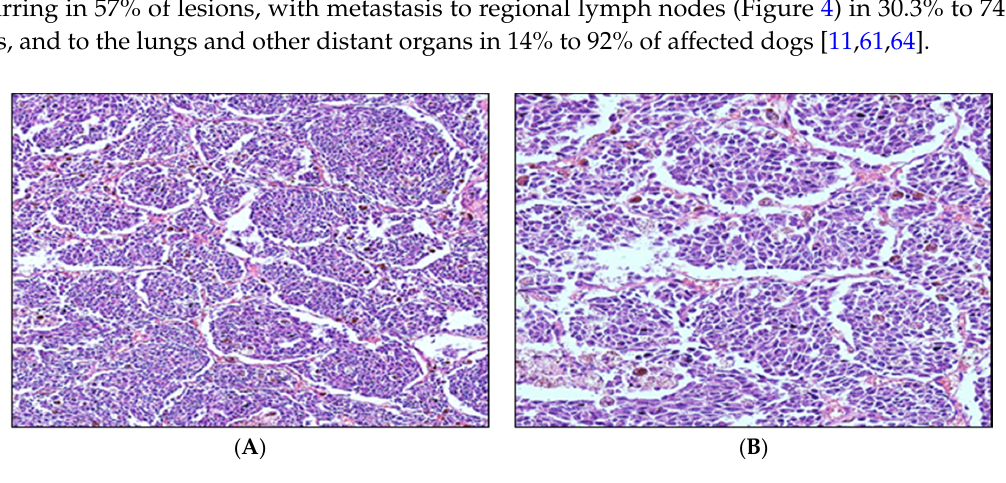
Figure 4. Photomicrograph of lymph node metastasis from oral melanocytic neoplasm (( A ), Objective 10x; ( B ), Objective 20x). Hematoxylin and eosin.